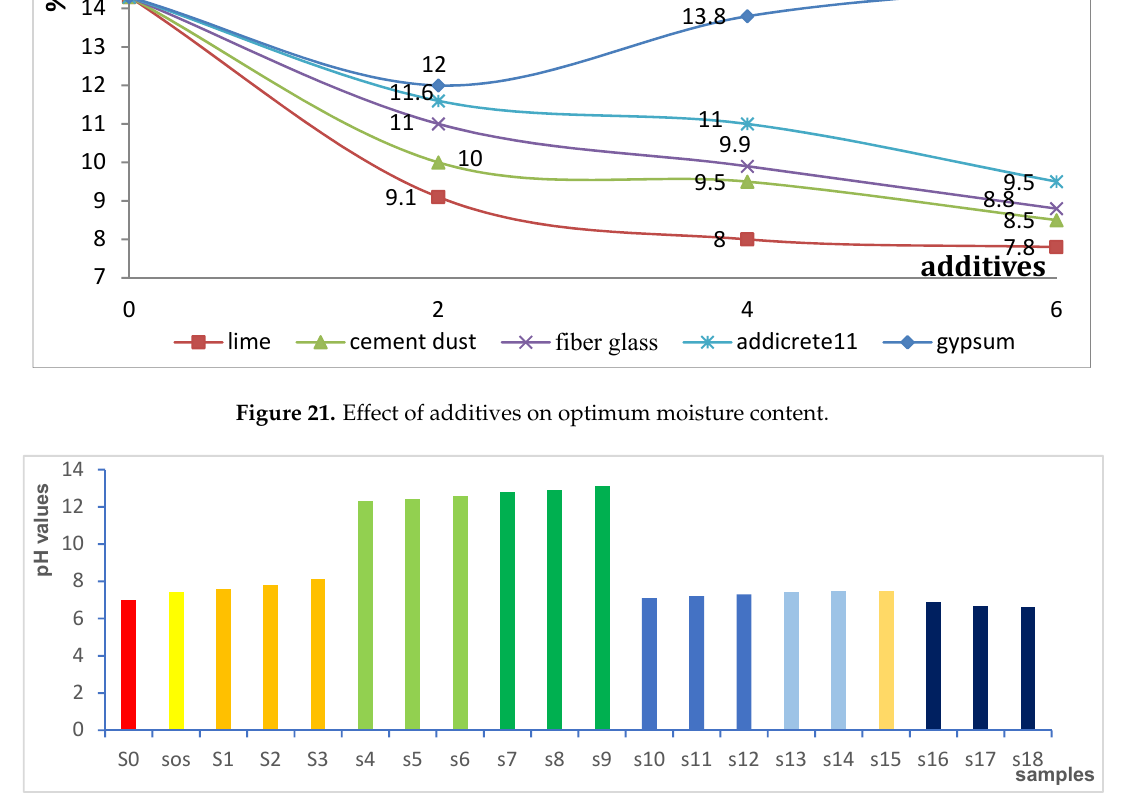
Figure 21. Effect of additives on optimum moisture content.